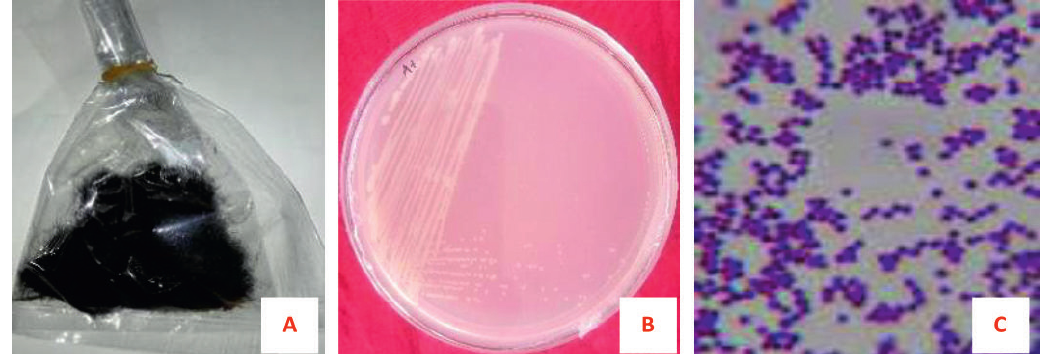
Fig. 1. Collection of hair samples, isolation of bacteria and gram staining of microorganism. (A) Hair sample (B) Isolated bacterial colonies and (C) Gram-positive